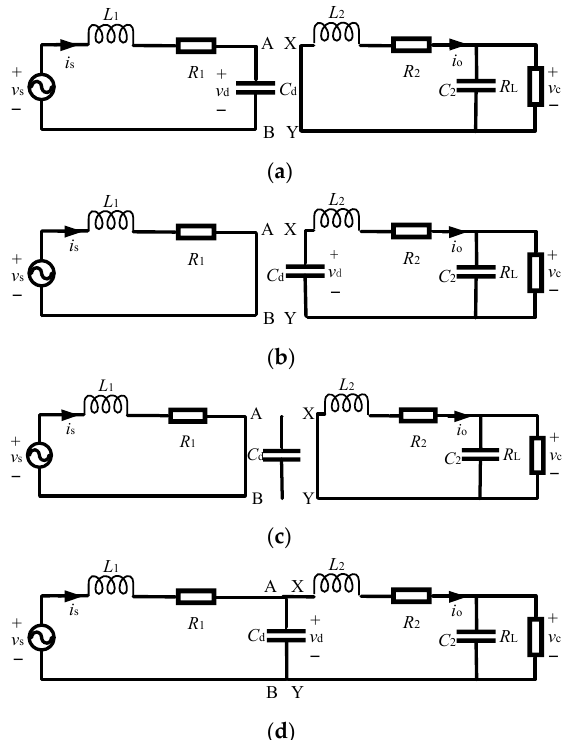
Figure 4. Four working states of the six-switch converter: ( a ) rectification state; ( b ) inversion state; ( c ) freewheeling state; ( d ) both-way state.